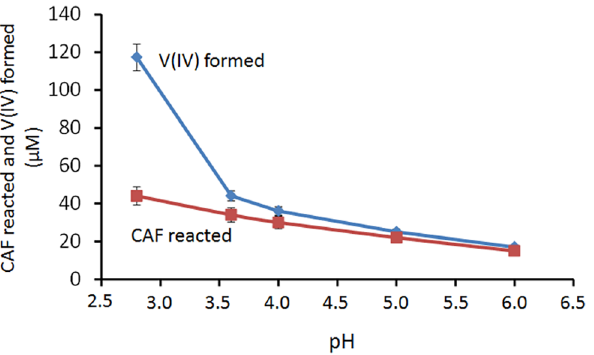
Fig 6. CAF reacted and V(IV) formed after 24 hours of reaction, as a function of pH, in the V(V)-CAF system with a V(V)/CAF molar ratio equal to 2.0. Initial conditions CAF 60 μ M, V(V) 120 μ M. Mean values ± standard